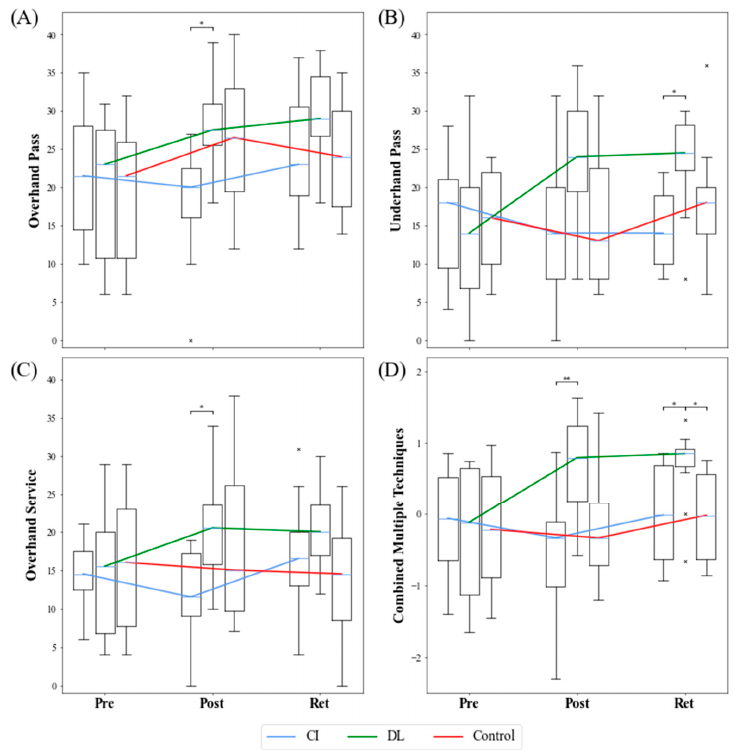
Figure 2. Development of the groups in the test on the respective skills over the duration of the measurement. Values are considered as outliers if they are outside the interval [Q1 − 1.5 × (Q3 − Q1), Q3 + 1.5 × (Q3 − Q1)]. × = outlier (each × stands for one outlier). Brackets show significant differences between the groups only. (* p ≤ 0.05; ** p ≤ 0.01). Shown are the boxplots of the overhand pass ( A ), underhand pass ( B ), overhand service ( C ), and combined multiple skills ( D ). For the clarity of the development of the groups, the median curves are also shown by line plots. CI = contextual interference group; DL = differential learning group; CO = control group; Pre = pre-test; Post = post-test; Ret = retention